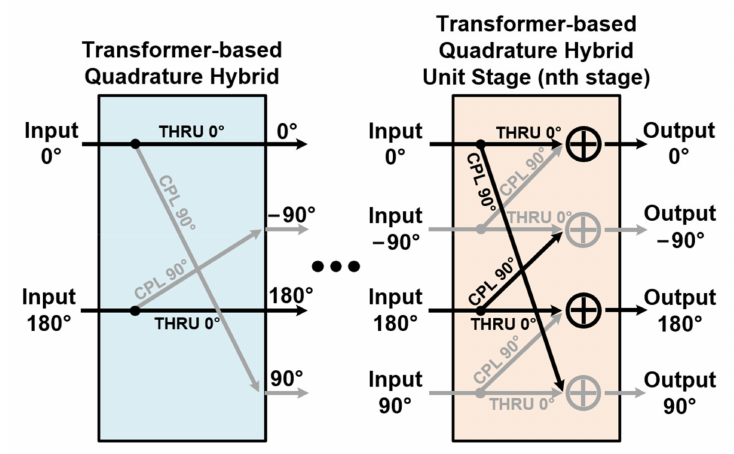
Figure 8. Polyphase signal combination scheme.